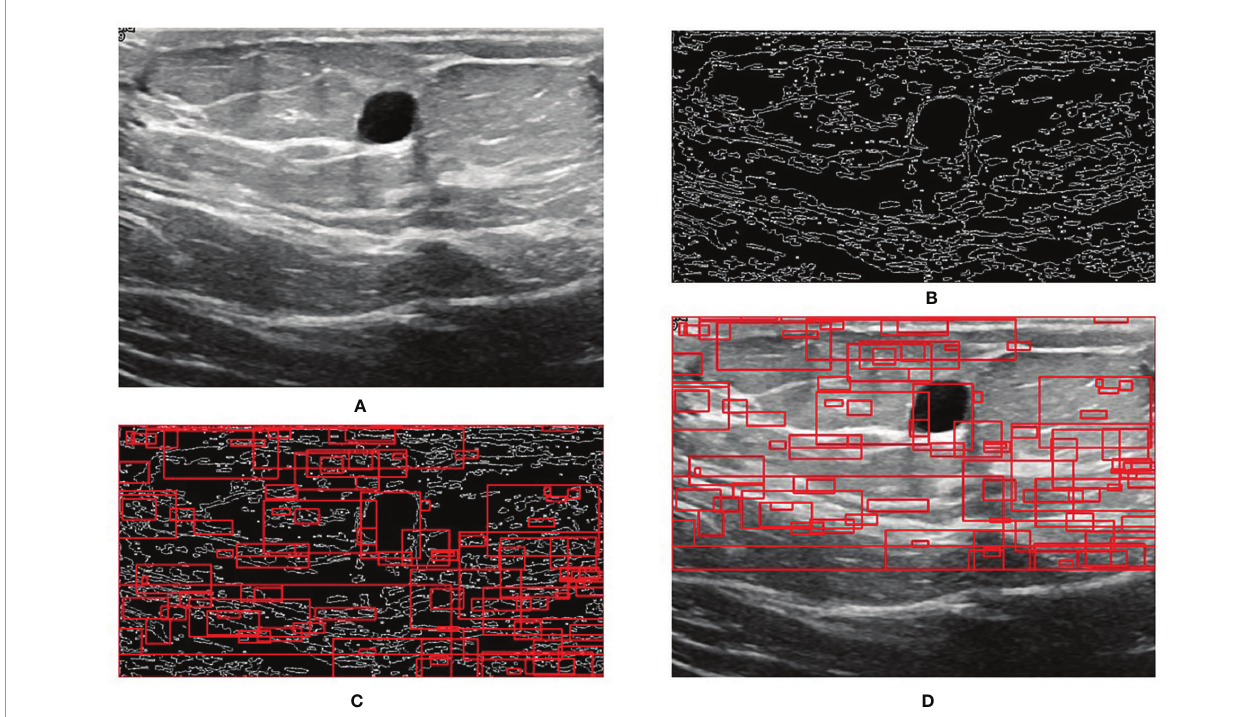
FIGURE 5 | Step-by-step process of RoI extraction. (A) Original image. (B) Edges obtained by Canny edge detector. (C) RoIs obtained by selective search. (D) RoIs on the original image.